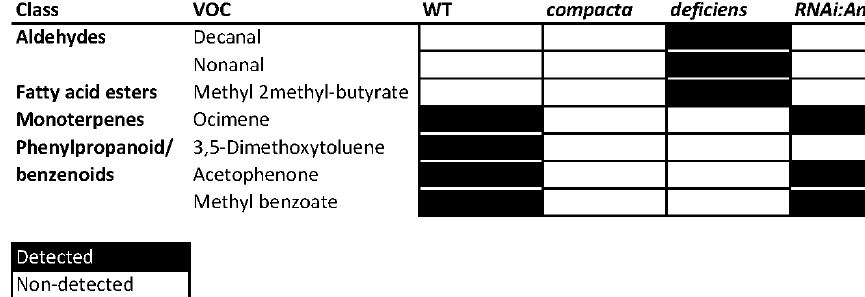
Figure 3. Heat map of constitutive by frequency scent profile of wild-type snapdragon (Sippe 50), the mutants co , def nic and the transgenic lines RNAi:AmLHY. We set minQuality to 80% (NormalizeWithinFiles function). Constitutive profile comprises those compounds present in 100% of analyzed samples. Volatile compounds are clustered by class. Black and white colors denote a detected and a non-detected compound, respectively.